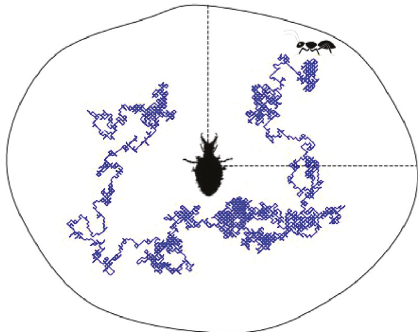
Figure 1: A schematic diagram of a random walk around the trap of